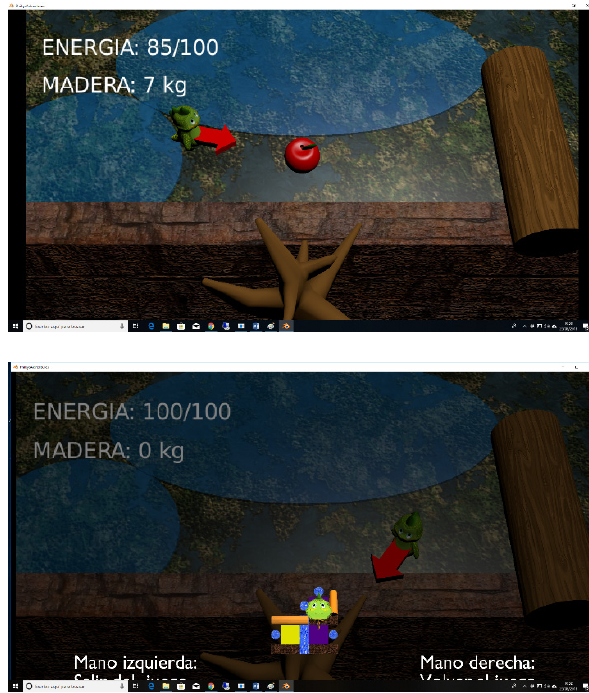
Fig. 6. Above: Illustration of motion amplification. Green sphere = user’s real maximum movement (photo); yellow sphere = scaled movement. Below: Character’s skeleton and Kinect skeleton with amplified arm